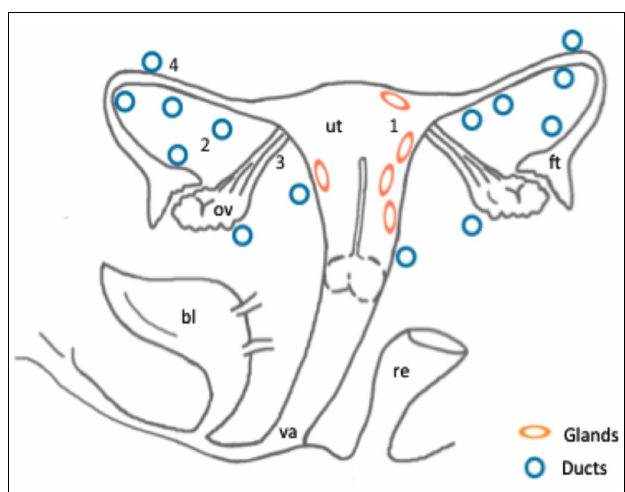
FIGURE 1 | Schematic representation of the anatomical localization of ectopic endometrial glands and embryonic duct remnants along the reproductive tract of six female fetuses. Areas of the distribution of ectopic glands in the myometrium (1) in two fetuses: (ellipses). Distribution of embryonic ducts in the uterine broad ligaments (2), ovarian ligaments (3), and under the fallopian tube serosa (4) in a total of six fetuses: (circles). Abbreviations: ut, uterus; bl, bladder; va, vagina; ov, ovary; ft, fallopian tube; re, rectum.